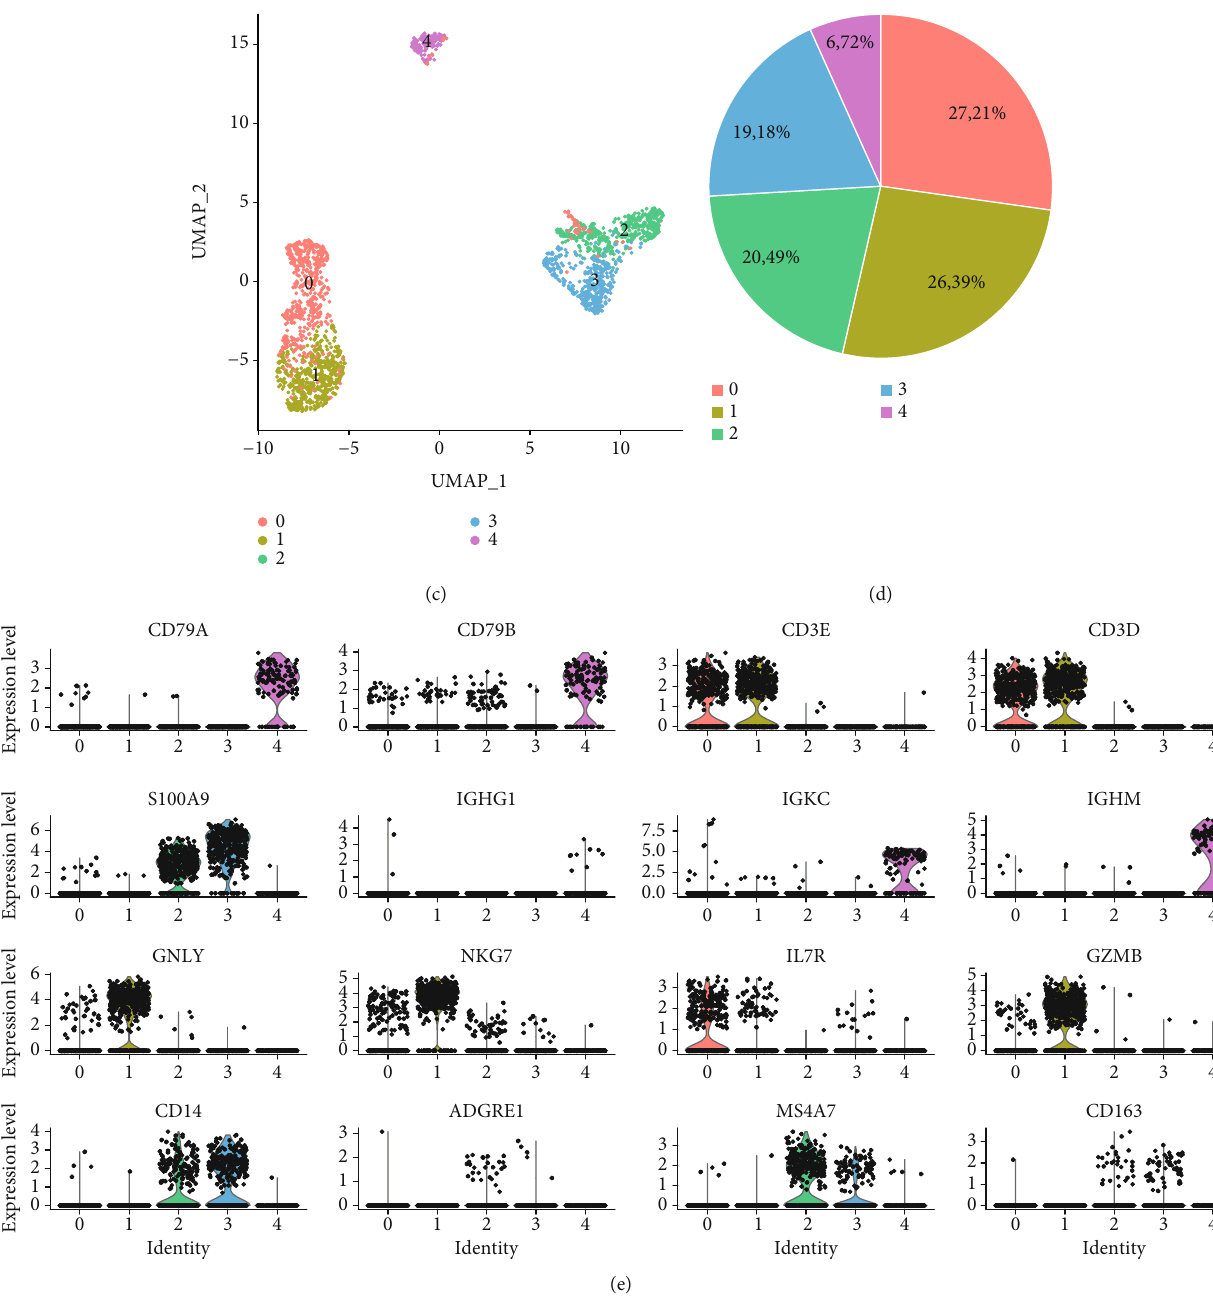
Figure 1: scRNA analysis of leukocytes in the kidney. (a) UMAP plot explored 12 clusters in the kidney tissue at a resolution of 0.25. (b) Gene expression of PTPRC indicated CD45+ leukocytes. (c) CD45+ leukocytes were subclustered into fi ve clusters. (d) Pie plot shows the frequency of each cell type. (e) The subclusters were annotated with known markers for T cells (CD3), monocyte/macrophages (CD14 and MS4A7), and B cells (CD79A/B). Violin plots showed the projection of indicated genes. IGG1 refers to memory B cells or plasma cells. (e) NKT cells were shown with marker genes such as GNLY, NKG7, and GZMB. The IL7R gene refers to conventional T